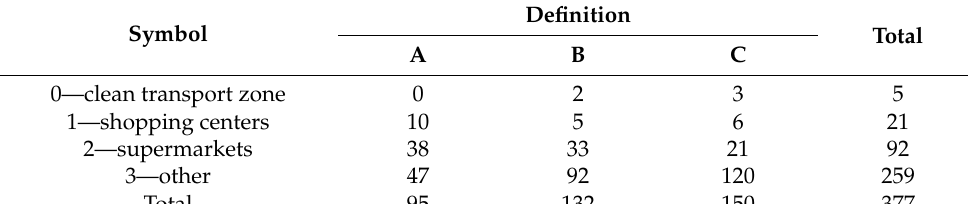
Table 3. The number of potential EVCS locations in each car park group in Poznan.